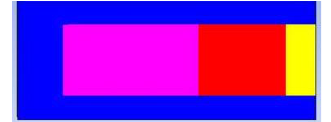
Figure 12. Metal block thickness activation model.